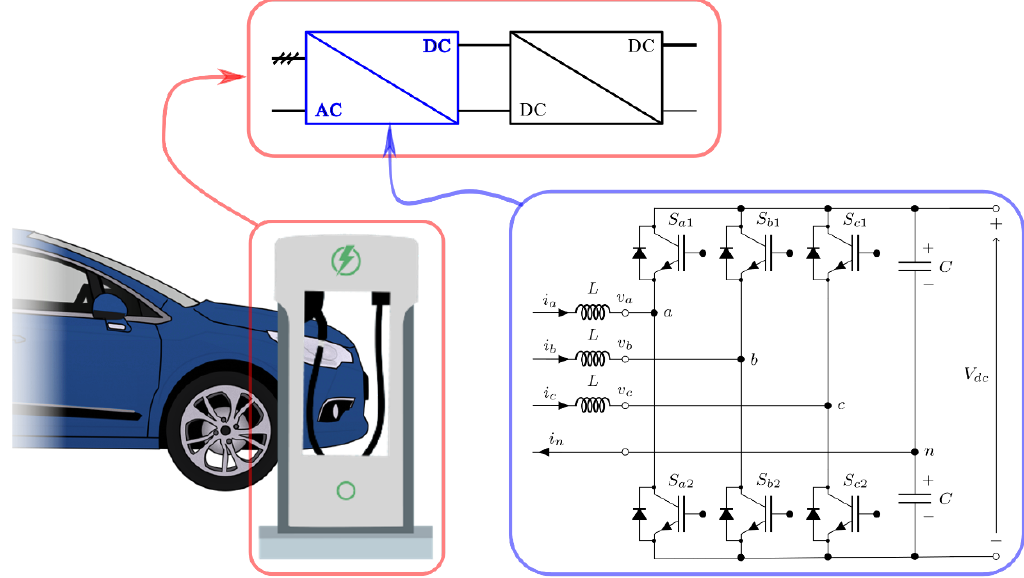
Figure 1. Circuit scheme of a three-phase four-wire split-capacitor converter and its possible location as active front-end in an off-board EV charging application.